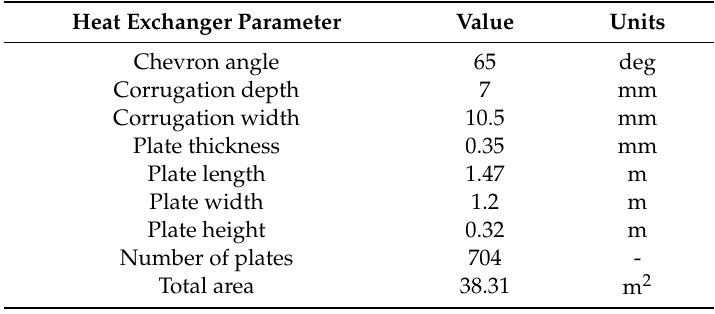
Table 5. Geometrical dimensions of the plate heat exchanger of the intercooler.